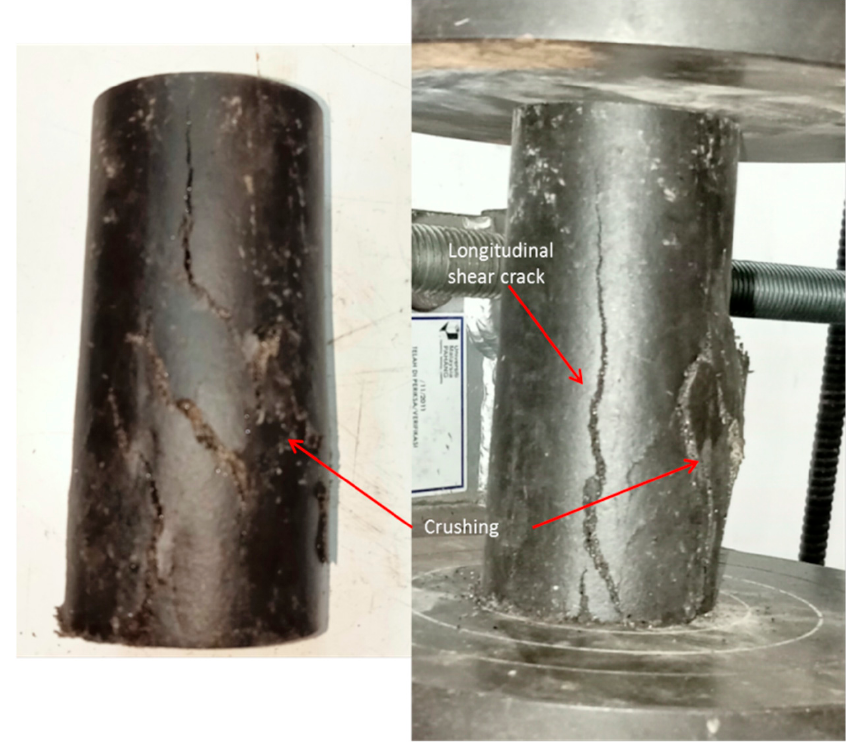
Figure 10. Failure modes of unconfined TSPC